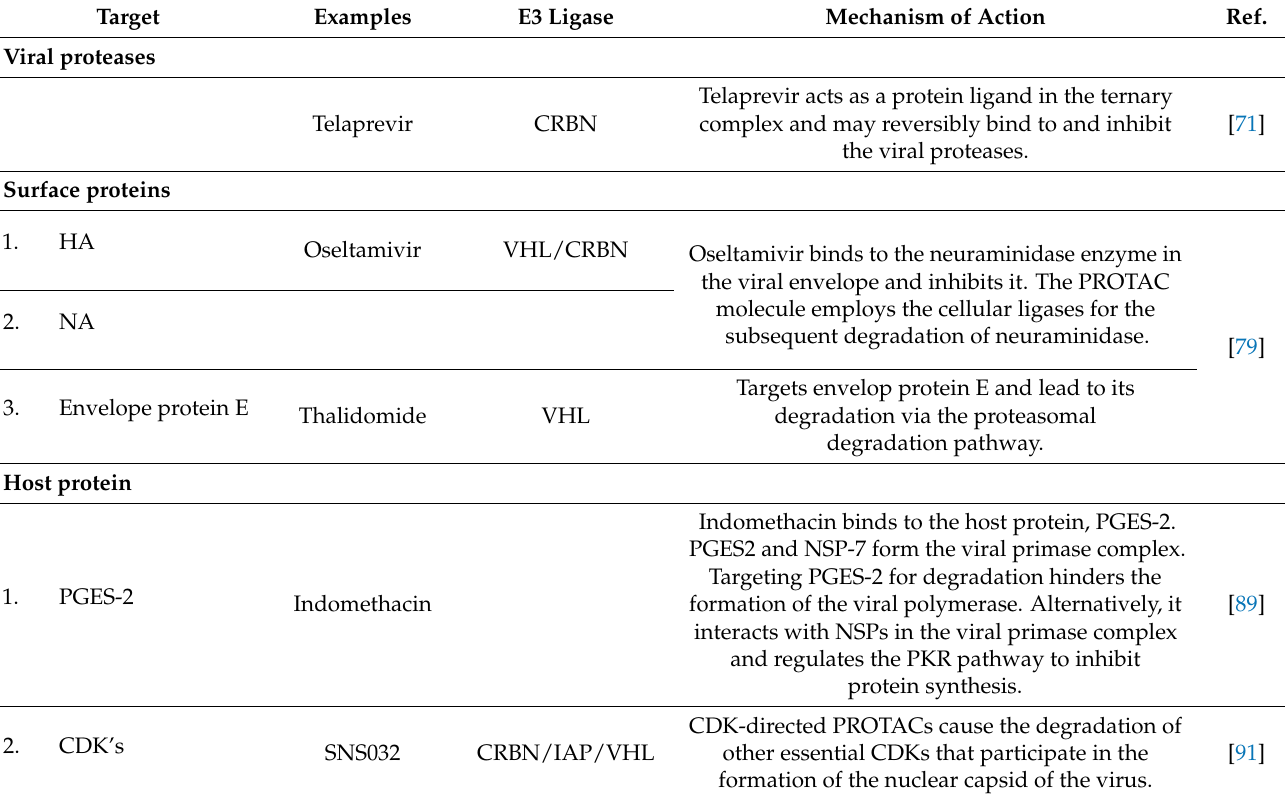
Table 1. Summary of PROTACs as an antiviral